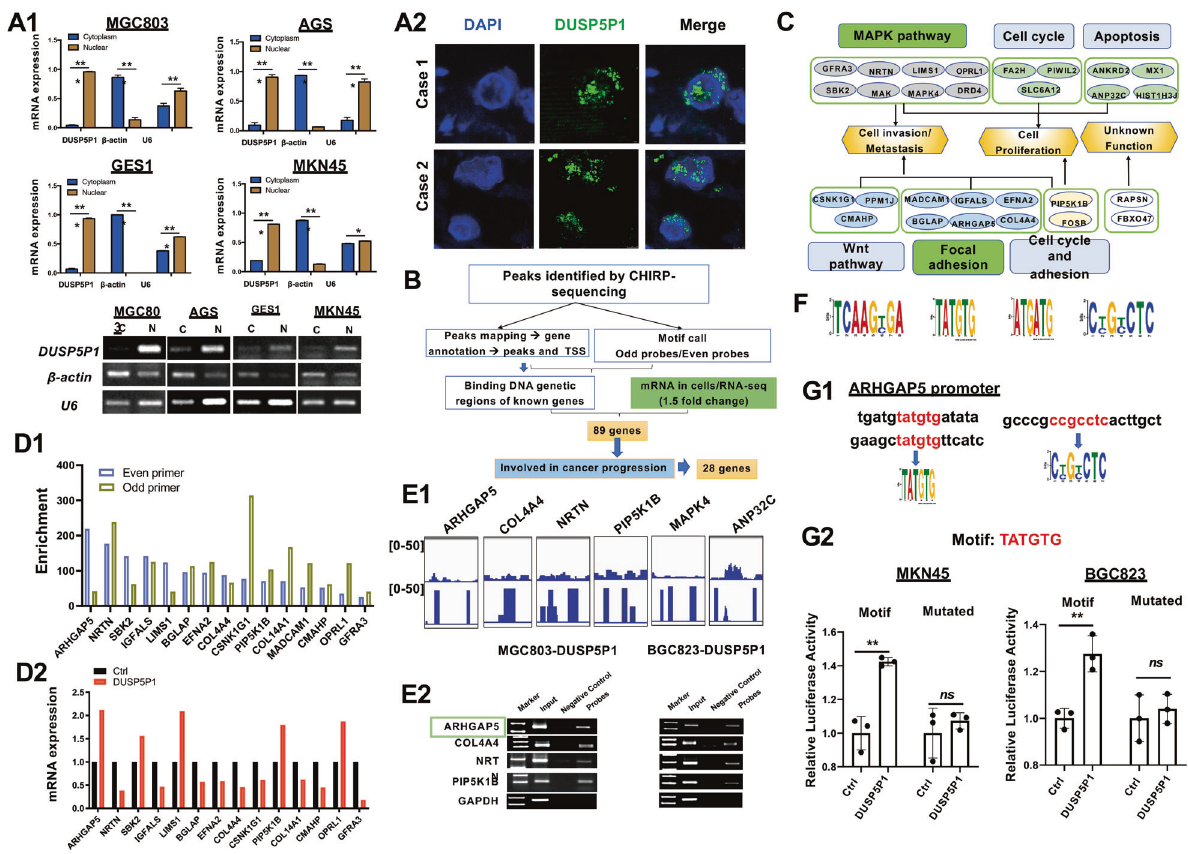
Fig. 4 ARHGAP5 is the direct downstream target of DUSP5P1. A Analysis of DUSP5P1 location. A1: DUSP5P1 was mainly located in the nucleus of GC cells by RT-PCR after nuclear and cytoplasmic fractionation. A2: Representative images of nuclear localization of DUSP5P1 in GC tissues by RNA FISH. A Nuclear localization of DUSP5P1 in DUSP5P1 overexpressed BGC823, GES1 and MGC803 cells following DUSP5P1 transfection by RNA FISH. B Flow chart of ChIRP-sequencing assay and RNA-sequencing data analysis of binding site for DUSP5P1 to select the direct downstream target genes of DUSP5P1. C The function and pathway enrichment of DUSP5P1 regulated target genes. D Downstream targets of DUSP5P1 identi fi ed by ChIRP-sequencing and RNA-sequencing. D1: The enrichment fold change of even and odd probes by ChIRP- sequencing and D2: the corresponding change of mRNA expression, respectively. E Validation of DUSP5P1 and binding target region of the downstream genes. E1: Representative visual images of enrichment feature of the target regions; E2: ChIRP-PCR was performed to determine the interaction between DUSP5P1 and target region of the downstream genes. F Motif analysis of target sequence by ChIRP-sequencing. G Analysis of motif ARHGAP5 binded. G1: The binding region and the motif analysis of the ARHGAP5 gene. G2: Luciferase reporter assay showed that DUSP5P1 binds to the “ TATGTG ” motif. * P < 0.05, ** P < 0.01, *** P < 0.001, **** P <